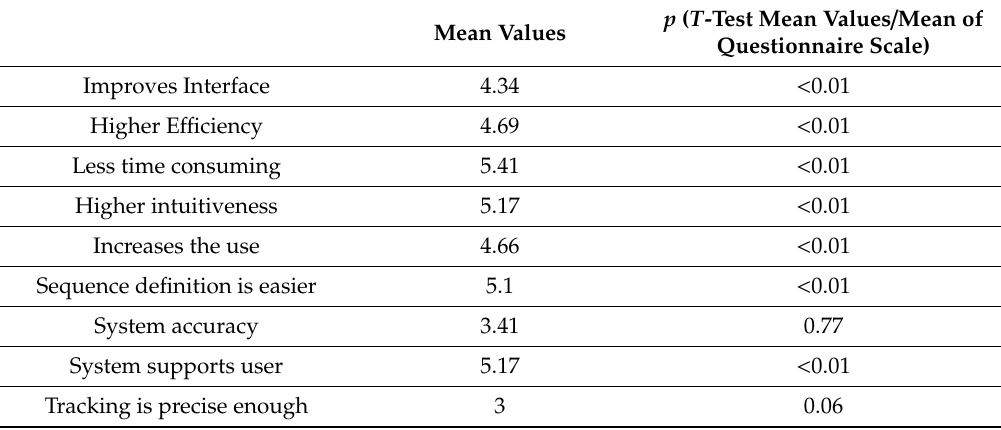
Table 2. Results of the final questionnaire about the VATS and the results of the t -test between the mean value of the results and the mean value of the scale. The p values with a grey background indicate the significant results of the t